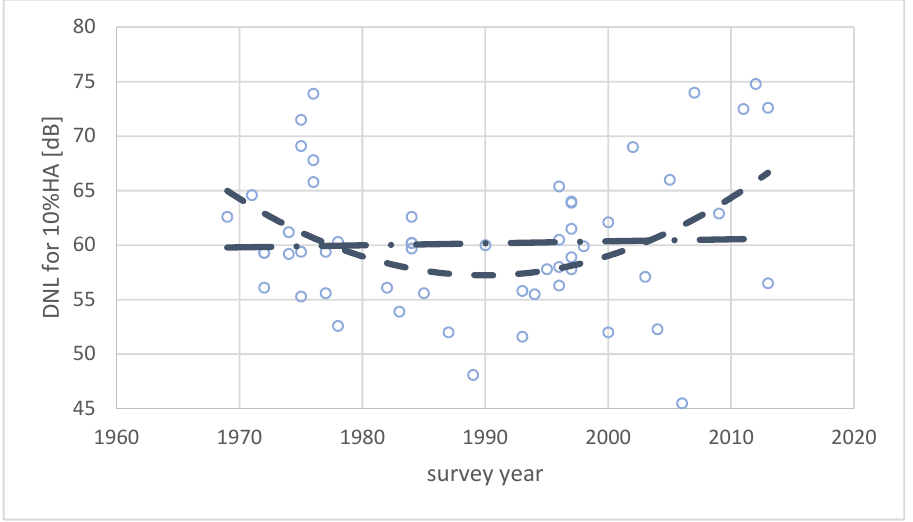
Figure 7. Noise exposure level at which 10% of the respondents are highly annoyed calculated for 61 surveys and plotted as a function of study year. The lines show a linear regression function (dash–dotted) and a second order polynomial regression function (dashed).